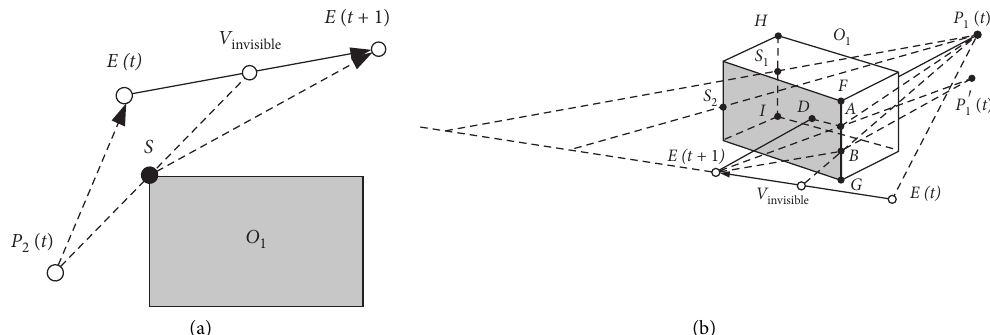
is in 2D. (b) When E just disappears, the 2